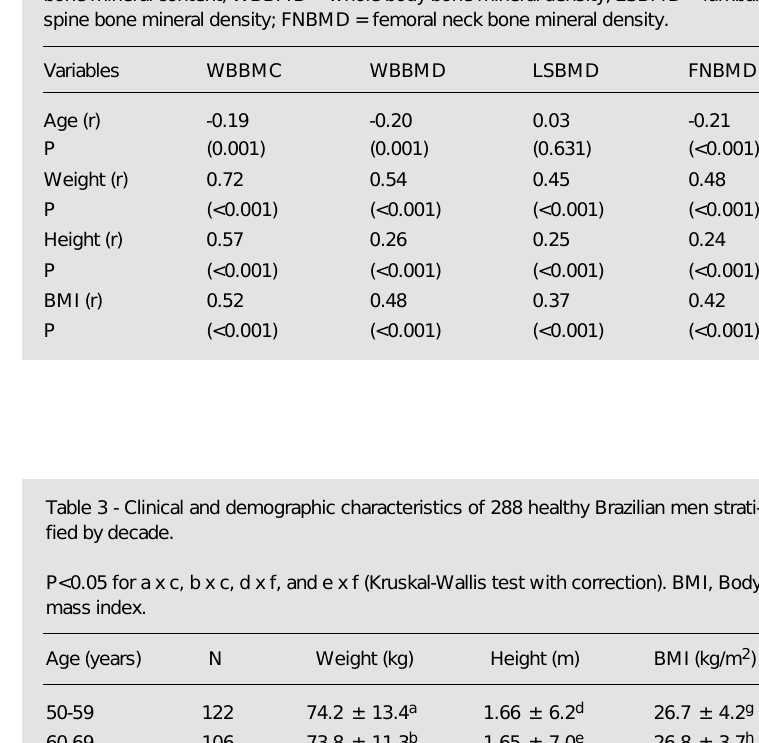
Table 2 - Correlations between body size and bone mass variables (N = 288